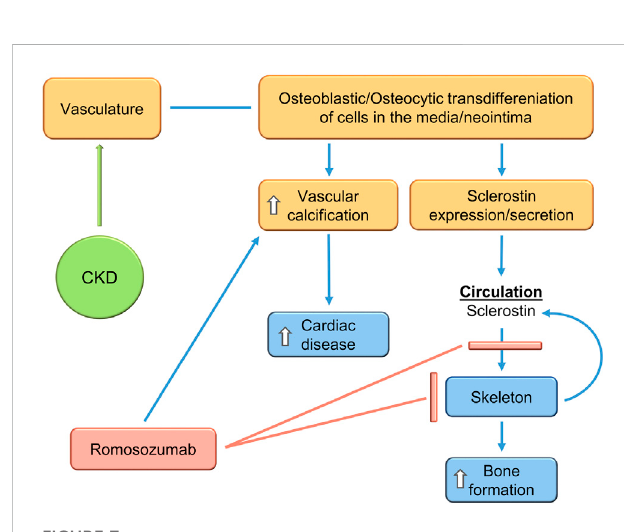
FIGURE 7 Treatment of the CKD-MBD using the antibody to sclerostin increases VSMC Wnt activity and osteoblastic transdifferentiation, stimulating vascular calci fi cation, but blocking systemic and skeletal sclerostin effects, thus stimulating bone formation. This would produce expected ef fi cacy in skeletal outcomes but worsen cardiovascular